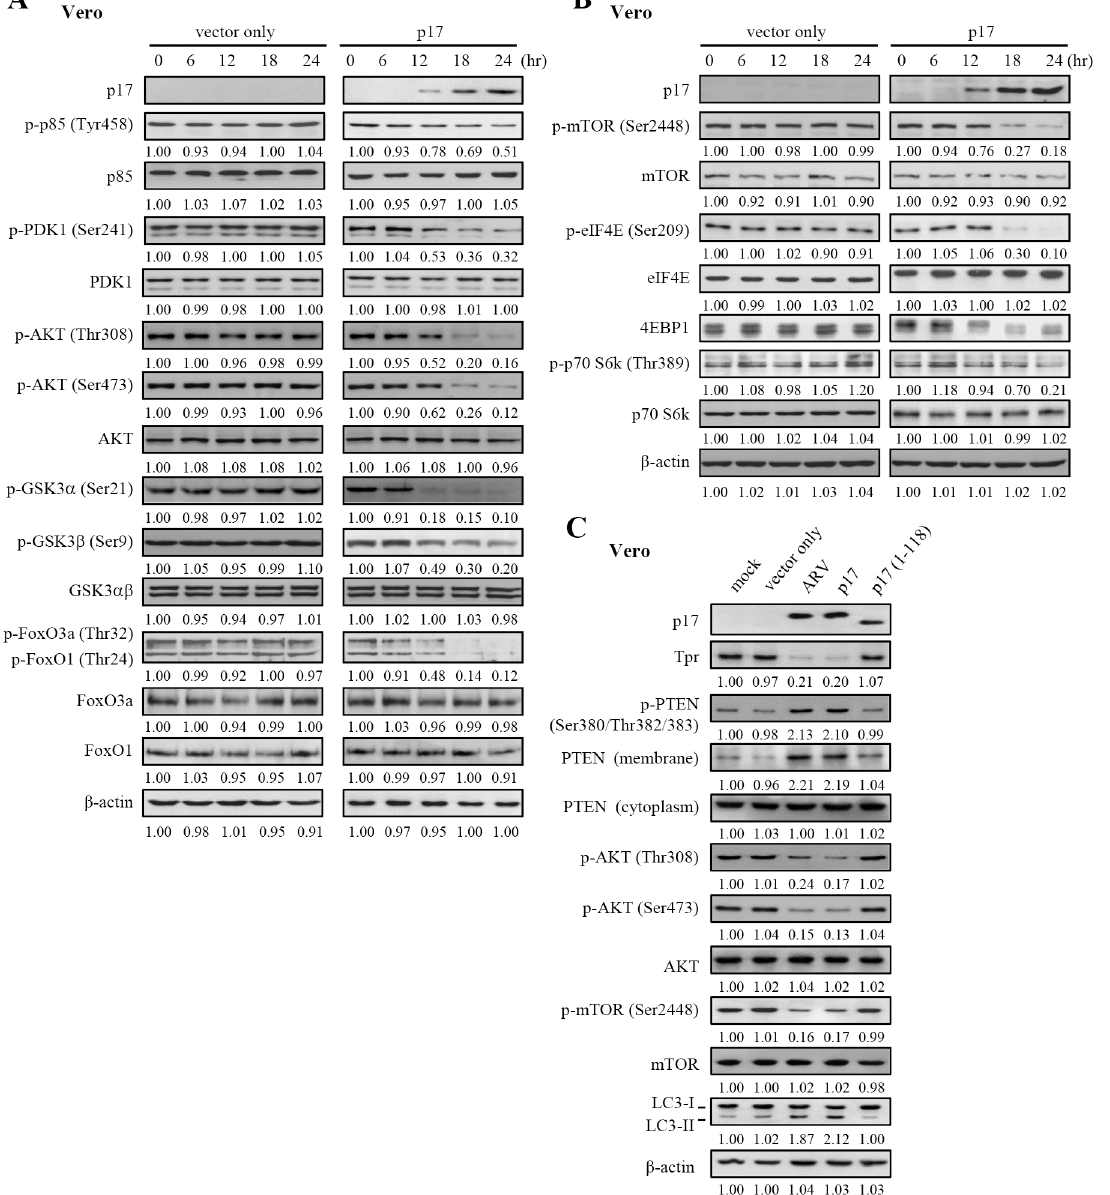
Fig 9. p17 negatively regulates PI3K/AKT/mTOR signaling pathway. (A-B) Vero cells were transfected with pcDNA3.1-p17 and pcDNA3.1 (vector only) plasmid, respectively for 24 hours. Whole cell lysates were collected at the indicated time points, and the levels of PI3K and its downstream molecules were examined by Western blot assay with the indicated antibodies. (B)Vero and DF-1 cells were co-transfected with both pcDNA3.1-p17 and p53 shRNAs for 24 hours, followed by Western blot analysis with indicated antibodies. Cells were also co-transfected with pCDNA3.1- p17 and respective negative controls (scrambled shRNAs and pGFP-V-RS vector) for 24 hours. (C) To study whether the negative control p17 mutant (1 – 118) can affect the levels of p-PTEN, p- AKT, p-mTOR, and LC3-II, vero cells were transfected with the p17 mutant (1 – 118) plasmid for 24 hours. Similar results were obtained from three independent experiments. The protein levels were normalized to those for β -actin.The activation and inactivation folds indicated below each lane were normalized against those at 0 h or mock. The levels of indicated proteins at 0 h or mock were considered